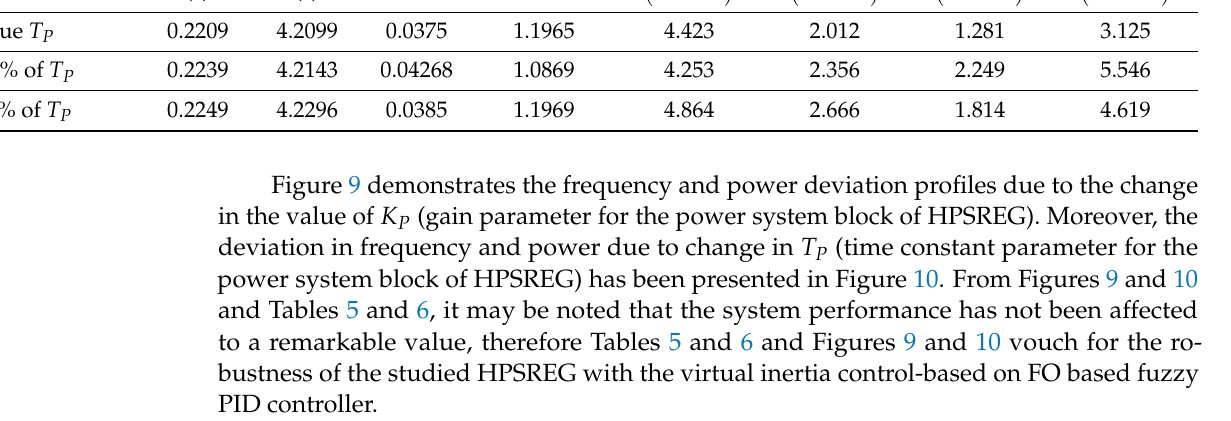
Table 6. Comparative study of dynamic responses offered by the HPSREG under parameter variation of T P . Parameter